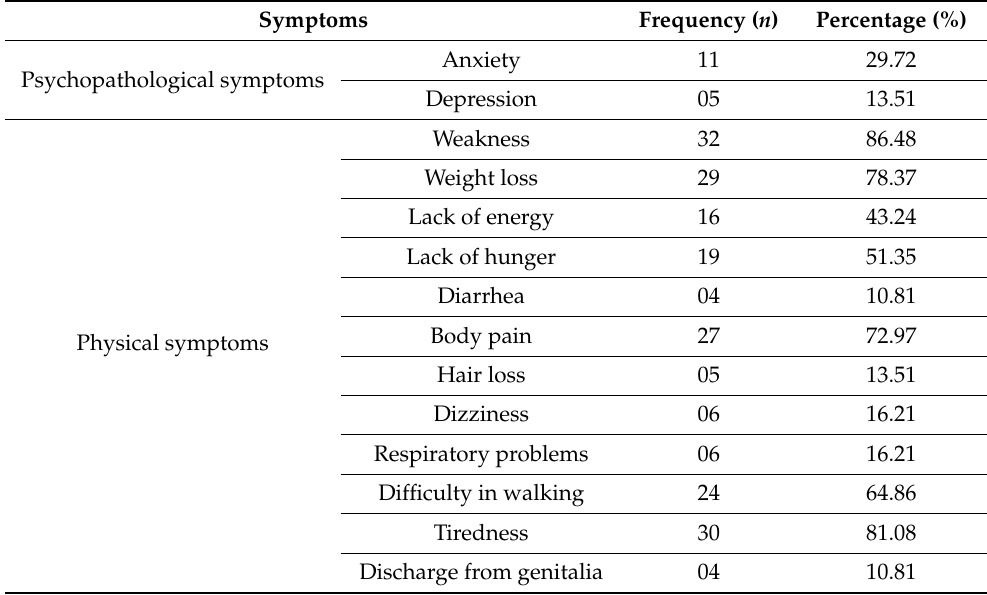
Table 4. The prevalence of common symptoms in studied HIV patients ( n =